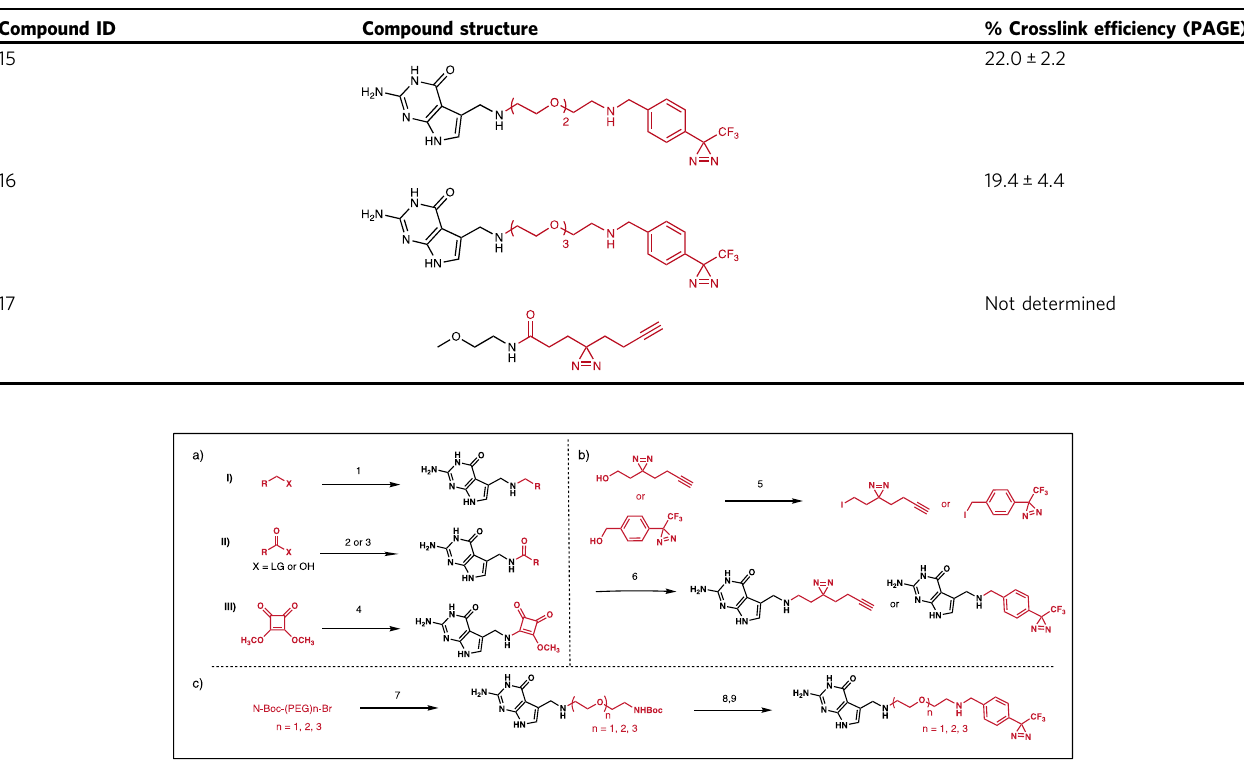
Fig. 1 Synthetic route for the preparation of chemical probes. Synthesis of electrophilic ( a ) and photoaf fi nity probes ( b , c ). (1) PreQ 1 , K 2 CO 3 , DMF, rt, 1 h; (2) PreQ 1 ,TEA, DMF, rt; (3) PreQ 1 , HATU, DIEA, DMF, 0 °C to rt 1 h; (4) PreQ 1 , TEA, DMF, rt, 18 h; (5) Ph 3 P, Imidazole, I 2 , DCM, 0 °C, 4 h; (6) PreQ 1 , K 2 CO 3 , DM rt, 2 h (in dark); (7) PreQ 1 , K 2 CO 3 , DMF, rt, 1 h; (9) Tri fl uoroacetic acid/DCM, 0 °C rt, 30 min; (8) PreQ 1 , K 2 CO 3 , DMF, rt, 2 h (in